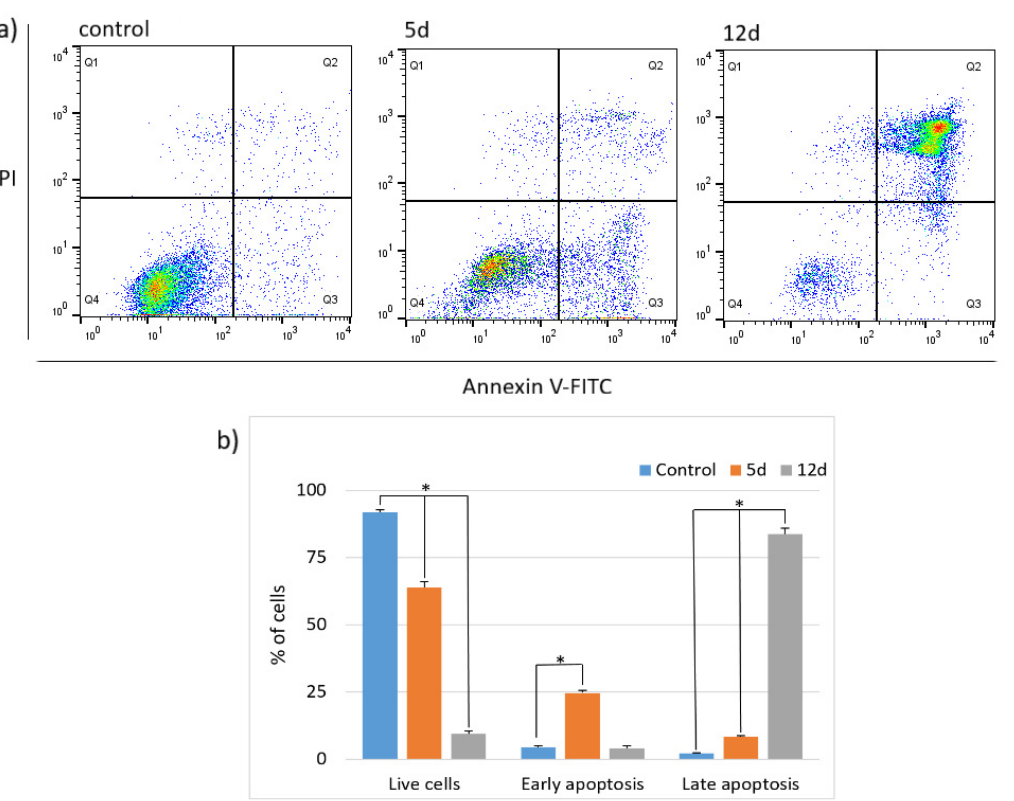
Figure 5. Detection of apoptosis in HuT78 cells after 24 h treatment with 5 µmol dm − 3 5d and 12d . Control cells were non-treated cells. Apoptosis was assessed by Alexa Fluor 488 annexin V/propidium iodide staining. ( a ) Representative scatter plots of control and treated samples. In each panel, quadrant Q4 shows live cells negative for both PI and Annexin V-FITC, whereas Q1 shows PI positive necrotic cells. Q3 presents early apoptotic cells positive for Annexin V-FITC, and Q2 shows late apoptotic cells positive for both Annexin V-FITC and PI. ( b ) Percentage of viable, early apoptotic and late apoptotic cells. Quantitative data are reported as average value ± SD. An asterisk (*) denotes values statistically significantly different when compared to the control ( p < 0.05).